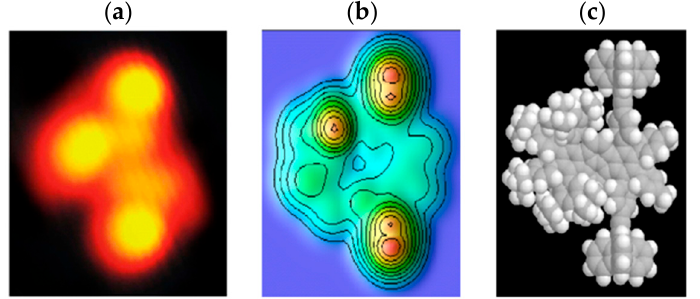
Figure 2. Experimental scanning tunneling microscope (STM) image (3 × 4 nm 2 , V = 0.5 V, I = 0.3 nA) on Cu(100) at 5 K ( a ) and the molecular conformation ( c ) corresponding to the electron scattering quantum chemistry (ESQC) calculated image ( b ).